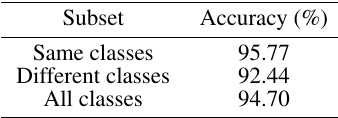
Table 9. Fine-tuning accuracies on UCM when different subsets of MLRSNet are used for DA